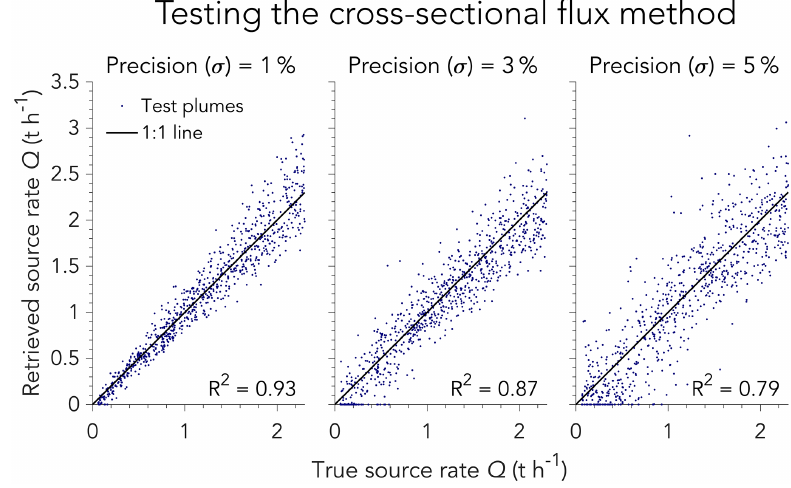
Figure 8. Evaluation of the cross-sectional flux method for retrieving source rates Q using the LES test set with three different instrument precisions (1%, 3%, 5%). The inset gives the coefficient of determination, R 2 .